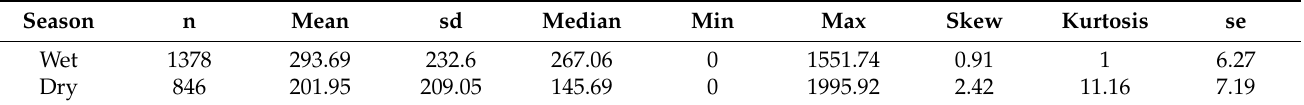
Table 6. Summary statistics for dry and wet seasons in the 1st component. Source: author’s pro- cessing.